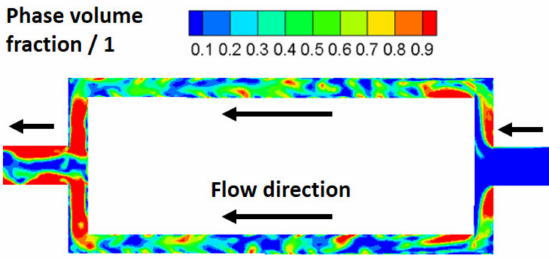
Figure 4. Two-phase flow regimes of parallel channels (y = 0.005 m).